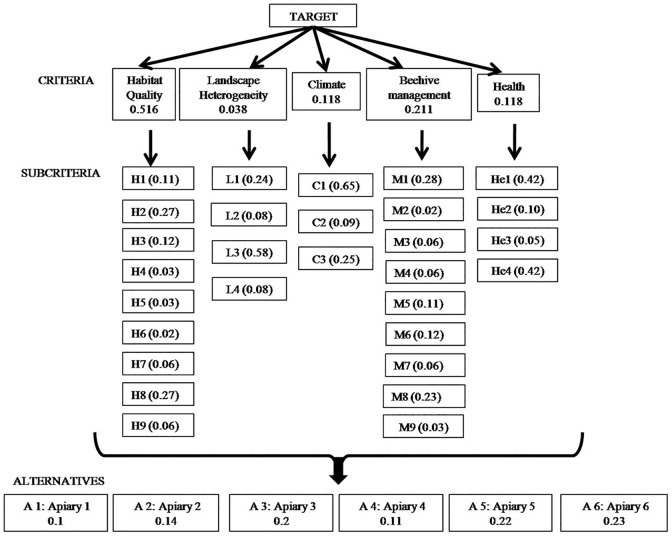
Analytic hierarchy process (AHP) to evaluate six apiaries in several natural environments.Development of criteria, subcriteria and alternatives to achieve the target, i. e. define the best alternative among possible. Numbers indicate relative weights of each criterion, subcriterion and alternatives.